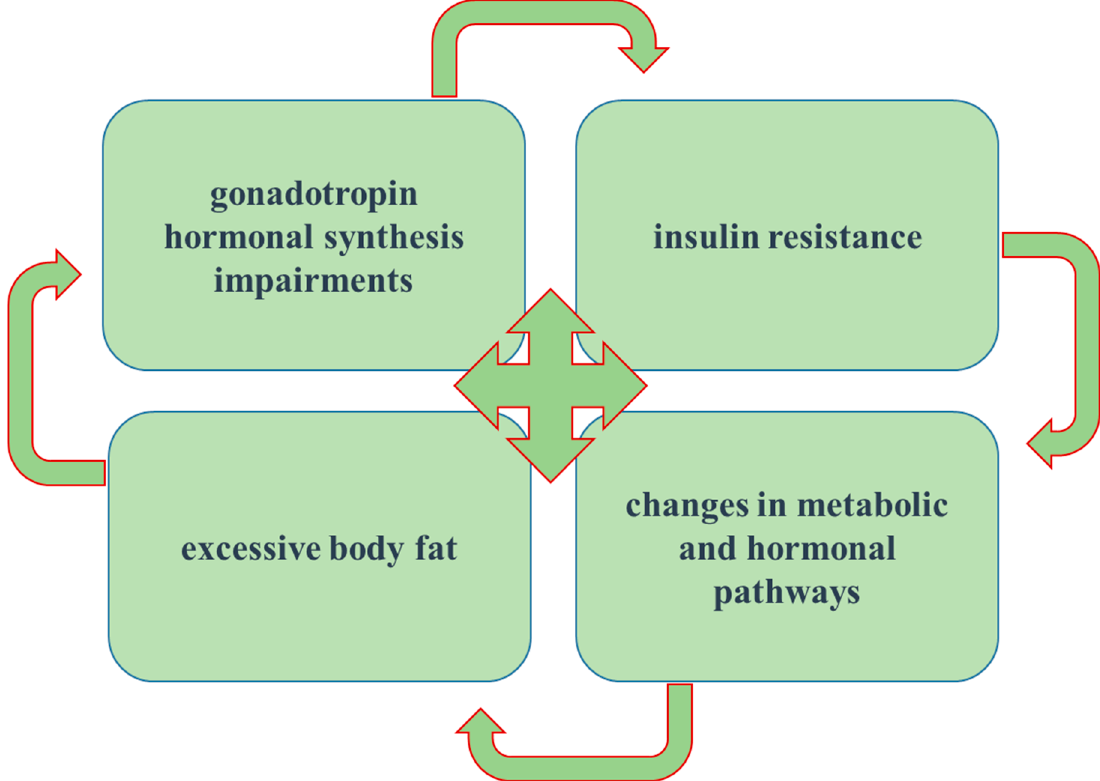
Figure 1. Main pathophysiological basis of polycystic ovary syndrome (PCOS)-disorders of gonadotropin hormonal synthesis, the appearance of insulin resistance, the influence of the present excessive body fat and oblique metabolic pathways involved in PCOS.